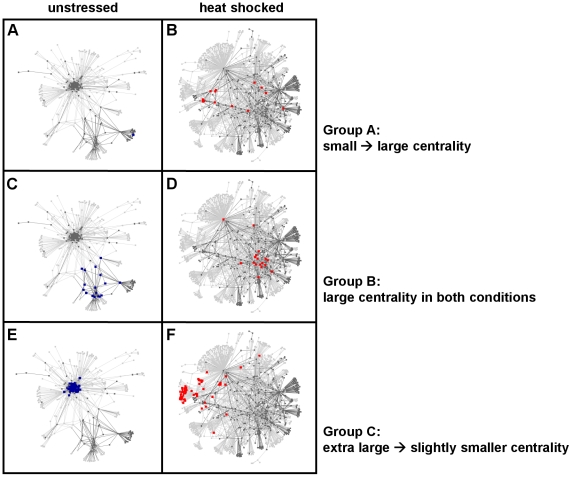
Topological positions of proteins with heat shock-altered community centrality in the network of the strongest interactions of the yeast interactome.Protein-protein interaction networks of unstressed (panels A, C and E) and heat shocked (15 min heat shock at 37°C; panels B, D and F) yeast cells were created as described in Materials and Methods. The subnetworks of their strongest links were determined and visualized as described in the legend of Figure 1. Similarly to the color-codes of Panels A and B of Figure 1, light grey colors denote the top 4%, while dark-grey colors the top 1% of interactions, respectively. Special groups of proteins with altered community centrality (Groups A through C, as described in the legend of Figure 4 and in Table S3 of Text S1) are marked with larger blue filled circles in the unstressed conditions (panels A, C and E) and with larger red filled circles in the heat shocked conditions (panels B, D and F), respectively. Panels A and B. Topological positions of ‘Group A’ proteins having a small→large community centrality transition upon heat shock. Only a single ‘Group A’ protein was among the top 4% of link weights in non-stressed condition (Panel A). ‘Group A’ proteins became visible and dispersed upon heat shock (Panel B). Panels C and D. Topological positions of ‘Group B’ proteins having large community centrality in both conditions. Proteins were condensed in one of the alternative centers before heat shock (Panel C) and became more dispersed after heat shock (Panel D). Panels E and F. Topological positions of group C proteins having an extra large→slightly smaller community centrality transition upon heat shock. Proteins were occupying the other alternative center of the subnetwork in unstressed condition (Panel E), and became dispersed upon heat shock (Panel F).